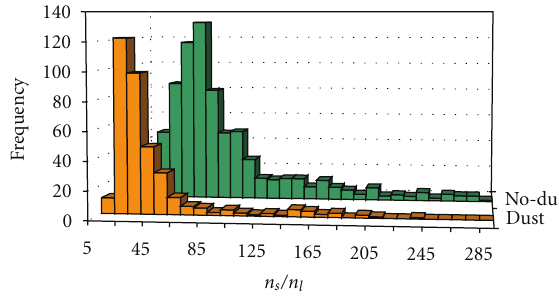
Figure 6: Histograms of n s /n l for dust and no-dust